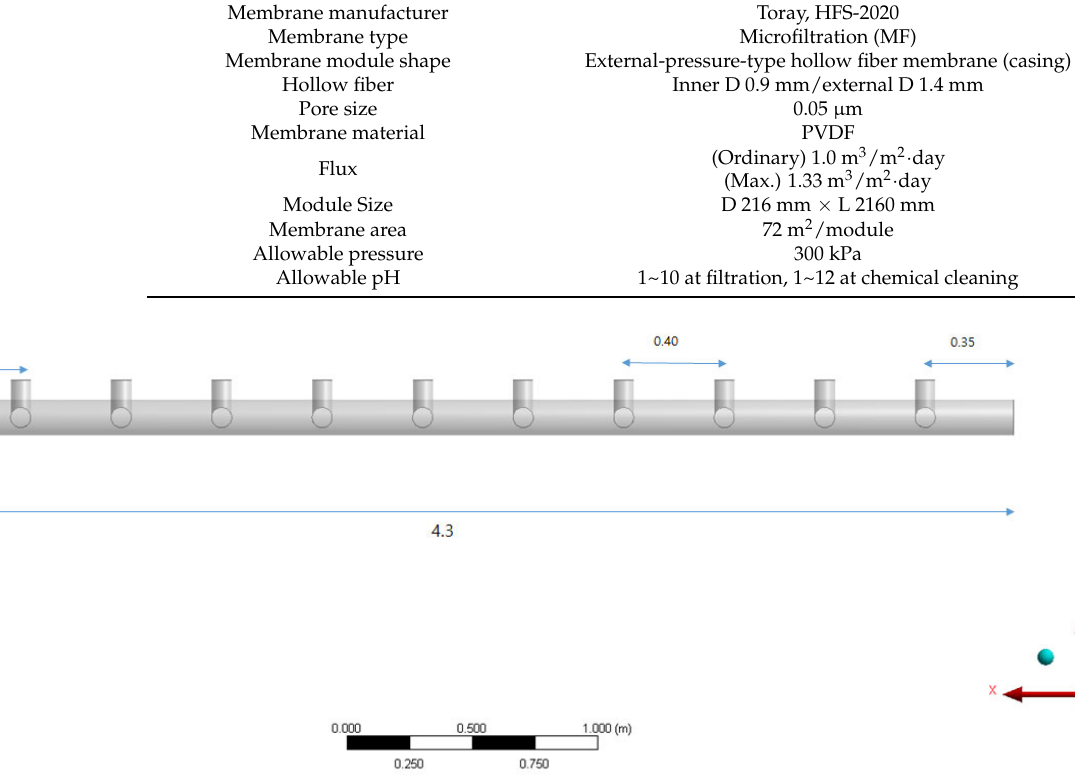
Figure 2. Geometry of inlet header and manifold pipes (unit: m).